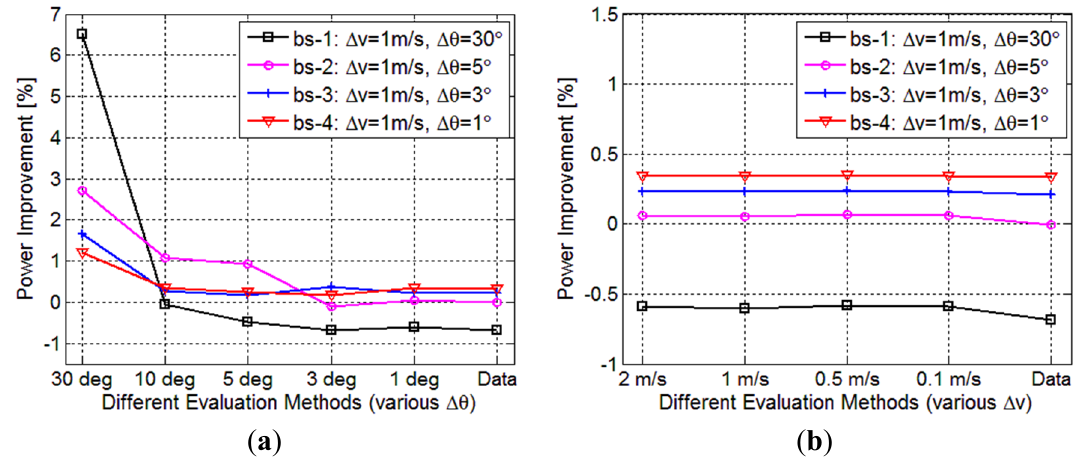
Figure 10. Power improvement of the optimized layouts, obtained with four bin size choices bs-1, bs-2, bs-3 and bs-4, re-evaluated with: ( a ) (cid:1986)(cid:1874) (cid:3404) 1 m/s and different (cid:1986)(cid:2016) ; ( b ) (cid:1986)(cid:2016) (cid:3404) 1° and different (cid:1986)(cid:1874) . (Note: ‘Data’ denotes those re-evaluated with measured